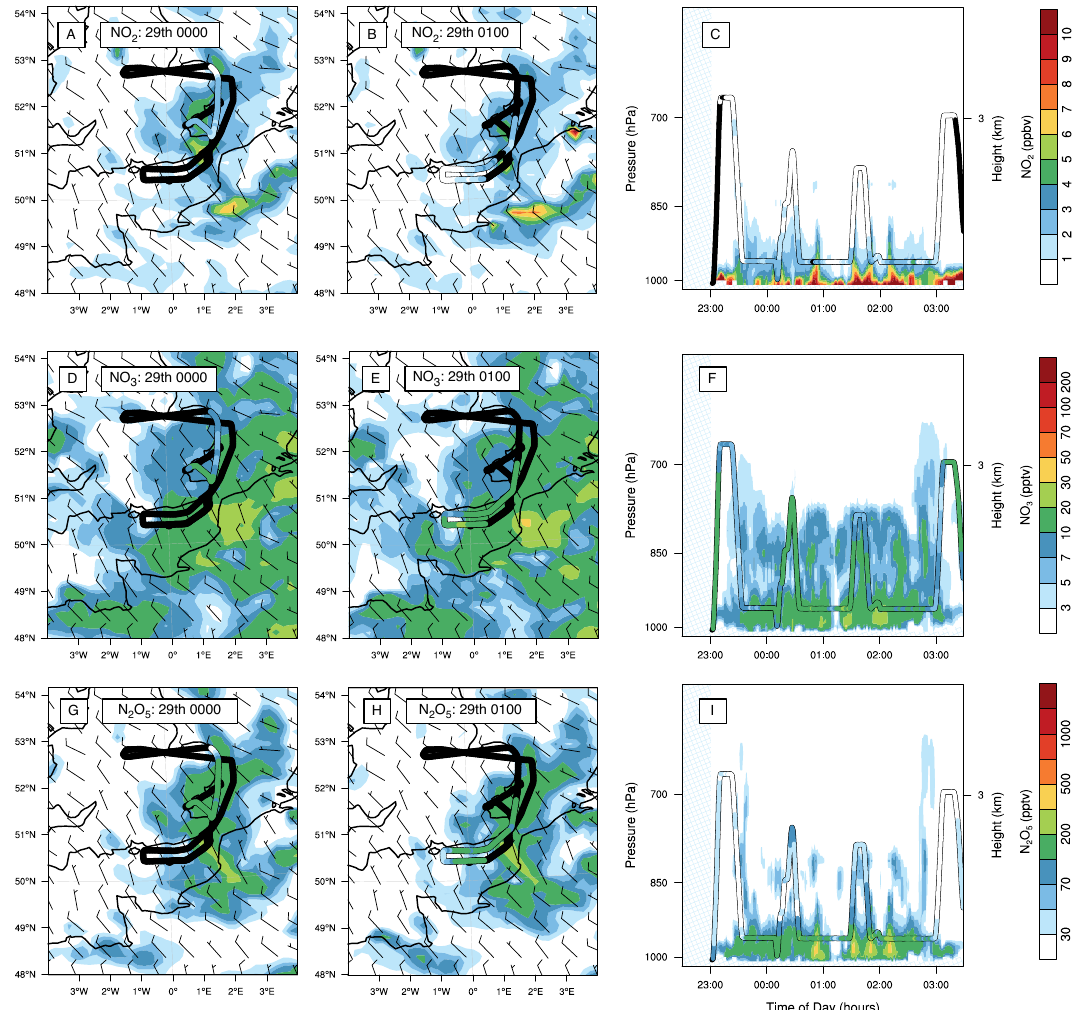
Figure 6. Comparison of NO 2 ( a–c ), NO 3 ( d–f ), and N 2 O 5 ( g–i ) measurements with regional model fields (from the “het on” scenario) for the B541 flight. ( a ) and ( b ), ( d ) and ( e ), and ( g ) and ( h ) show model fields interpolated to 960hPa at the times indicated in each panel, compared with measurements which are made within ± 30min of that time, and within ± 10hPa of the interpolated model pressure level. ( c ), ( f ), and ( i ) show the vertical distribution of the model fields along the flight path (extracted ± 30min either side of each output time), with measurement data along the flight path. See the main text for full description.